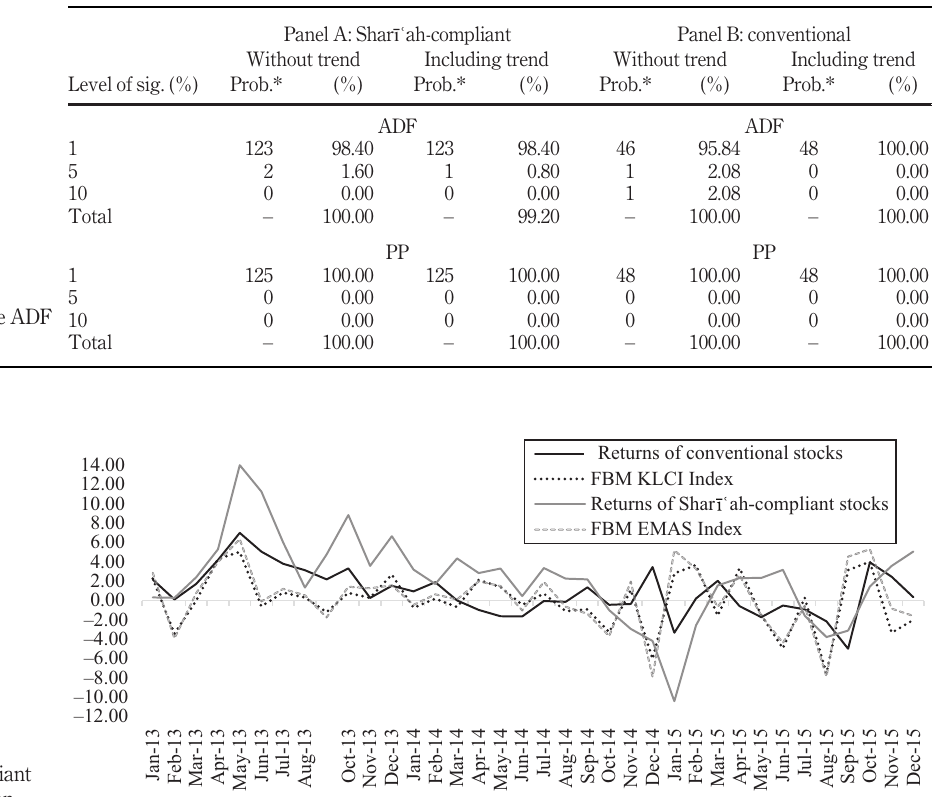
Figure 1. Performance of Shar ī ʿ ah-compliant and Shar ī ʿ ah non- compliant stocks relative to